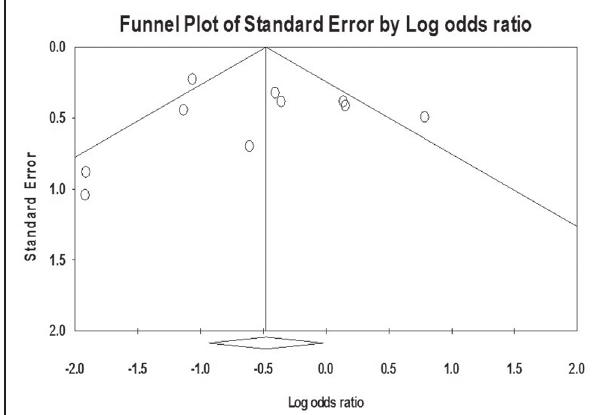
Figure 3) Funnel plot of standard error according to hepatitis B virus trans- mission